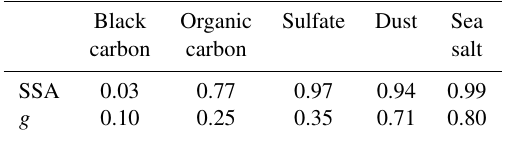
Table 2. Aerosol single scattering properties, computed using the GOCART model ∗ , for the five types of aerosols (black carbon, or- ganic carbon, sulfate, dust, and sea salt) used in the study. Single Scattering Albedo (SSA) and asymmetry parameter ( g ) are aver- aged values over the 15 H 2 O absorption